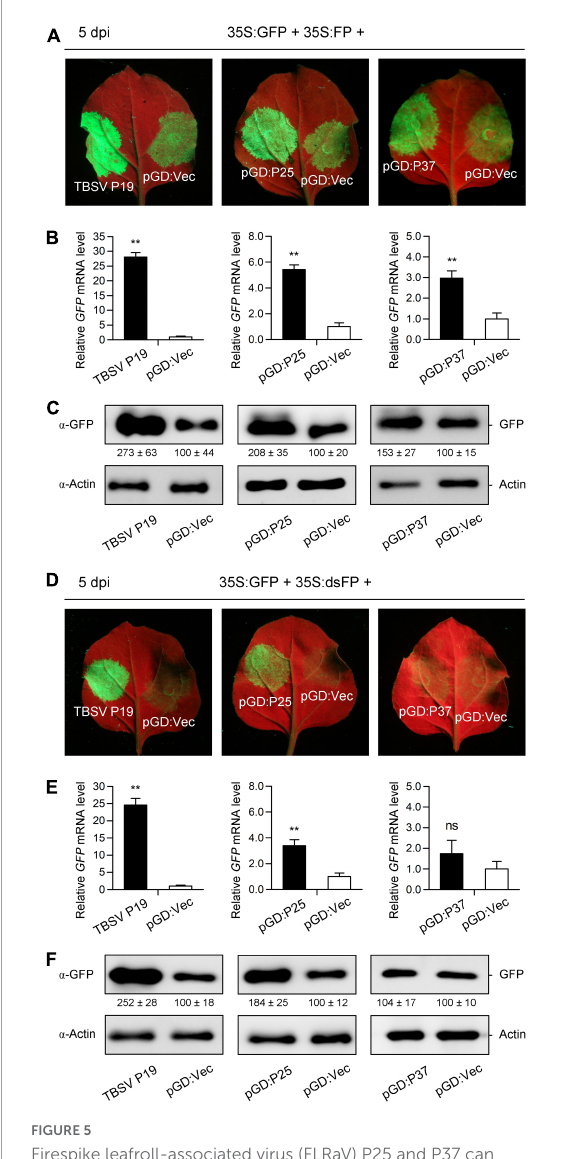
FIGURE5 Firespike leafroll-associated virus (FLRaV) P25 and P37 can inhibit the post-transcriptional gene silencing (PTGS) of green fluorescent protein (GFP) mainly in a sense RNA manner. (A) Wild-type Nicotiana benthamiana seedlings were co-infiltrated with Agrobacterium tumefaciens containing the binary vector expressing GFP (35S:GFP) and 35S:FP (a C-terminal 400-bp fragment of sense GFP mRNA) plus pGD:Vec, TBSV P19, pGD:P25, or pGD:P37 at 5 days post infiltration (dpi). Leaves of N. benthamiana seedlings co-infiltrated with A. tumefaciens